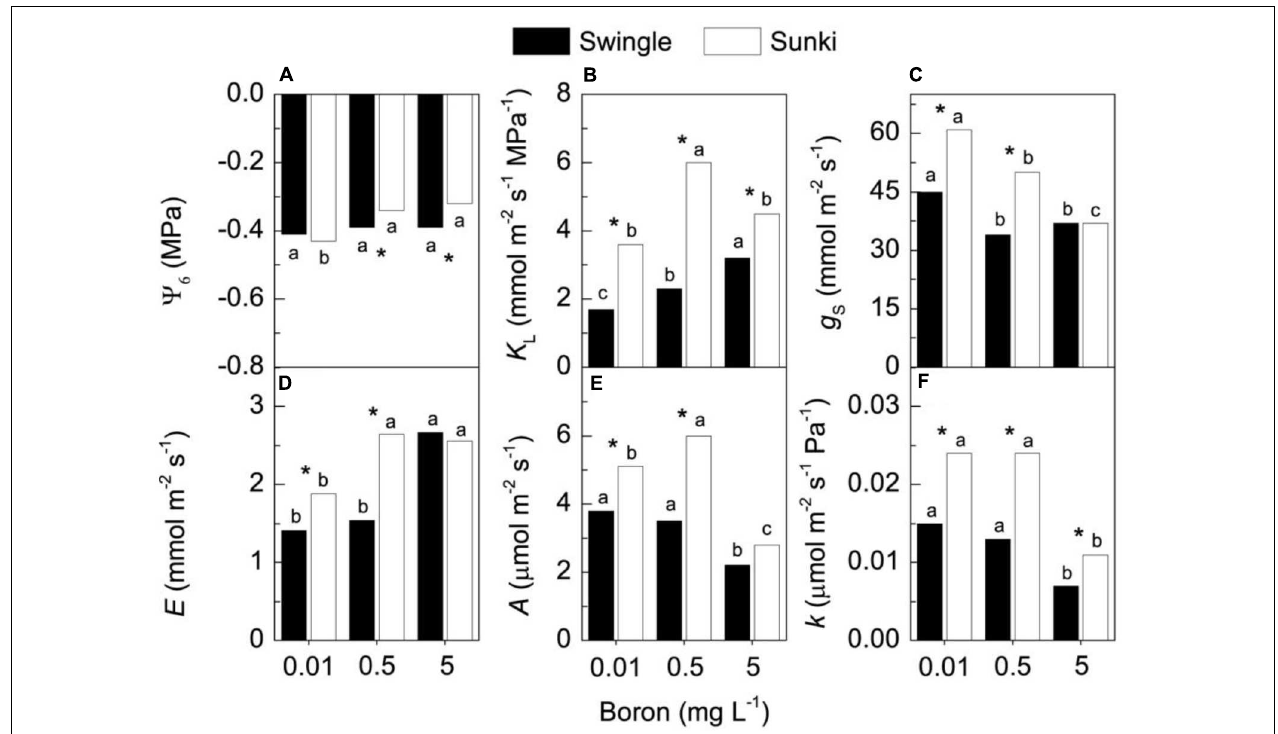
FIGURE 4 | Leaf water potential (A), whole-plant leaf specific hydraulic conductance (B), stomatal conductance (C), transpiration (D), CO 2 assimilation (E) and instantaneous carboxylation efficiency (F) in sweet orange trees grafted on Swingle or Sunki rootstocks grown in nutrient solution with varying concentrations of boron for 130 days. Asterisks compare rootstocks in a given boron concentration, whereas lowercase letters indicate significant difference between boron concentrations in a given rootstock (Tukey test at p <